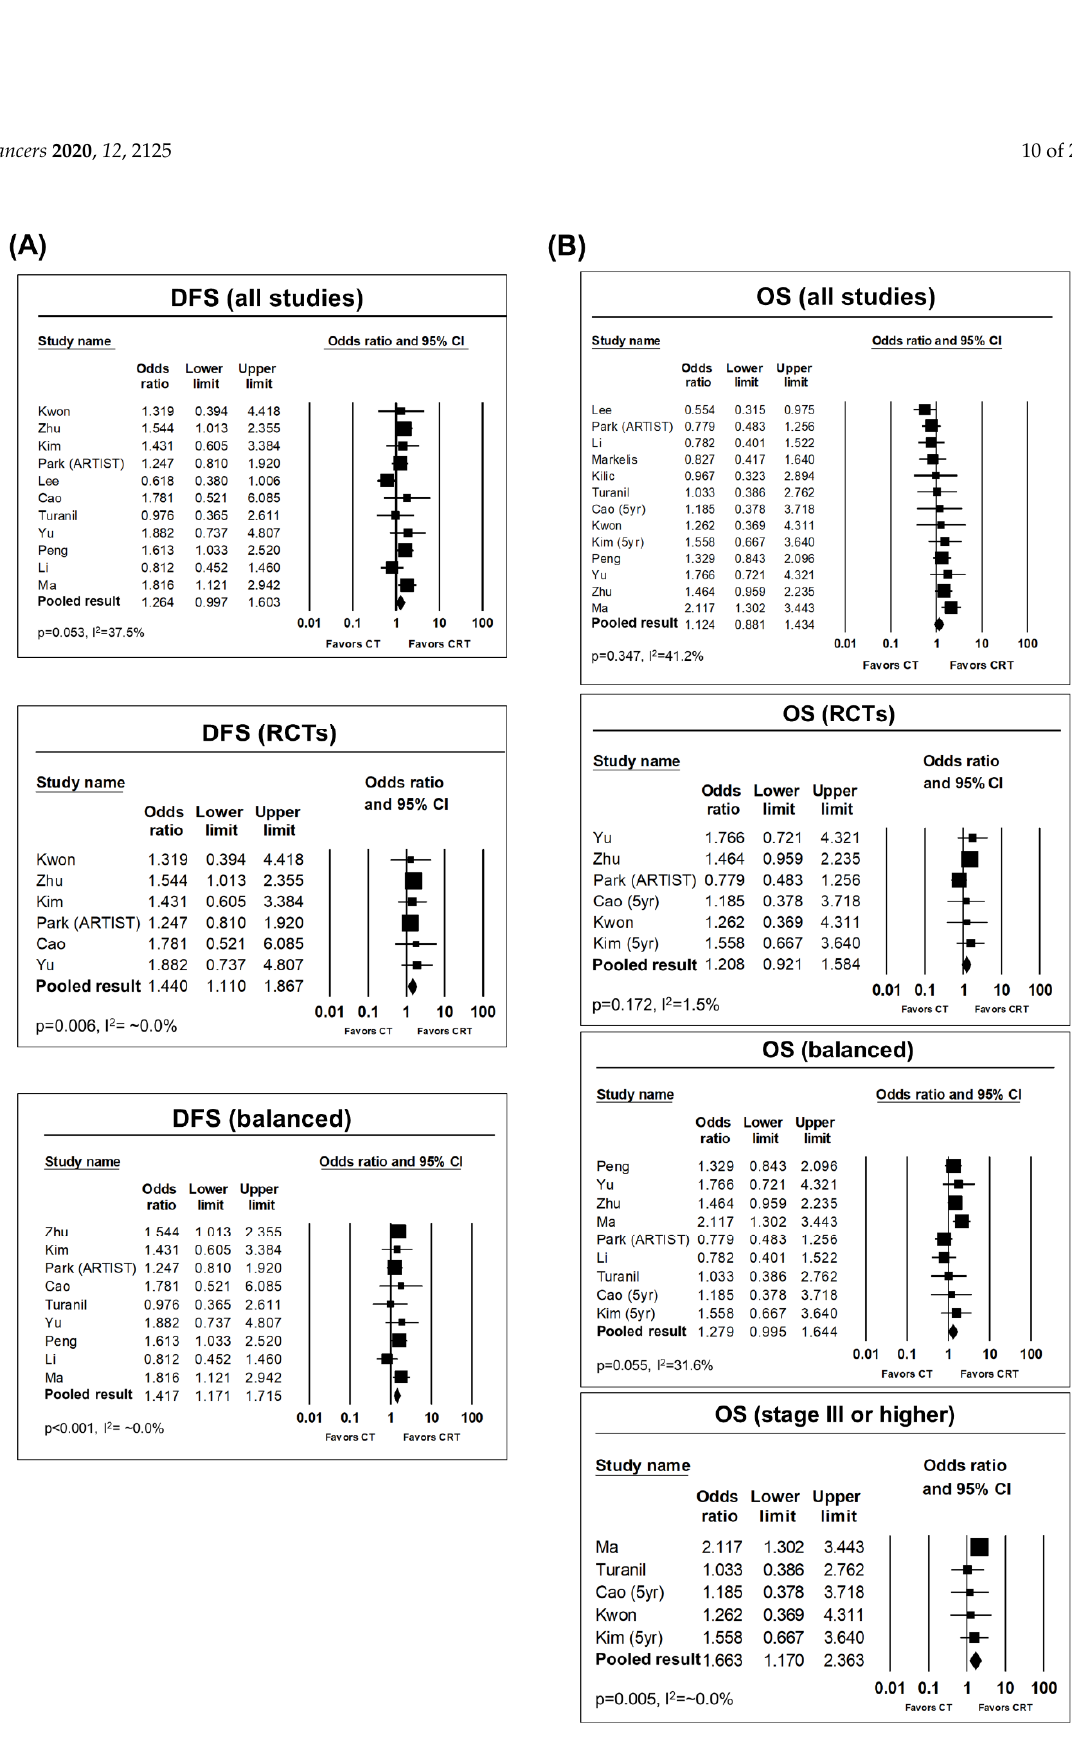
Figure 2. ( A ) Forest plots of overall and subgroup pooled analyses of 3-year disease-free survival (DFS). ( B ) Forest plots of overall and subgroup pooled analyses of 3-year overall survival (OS). CI, confidence interval; RCT, randomized controlled trial.